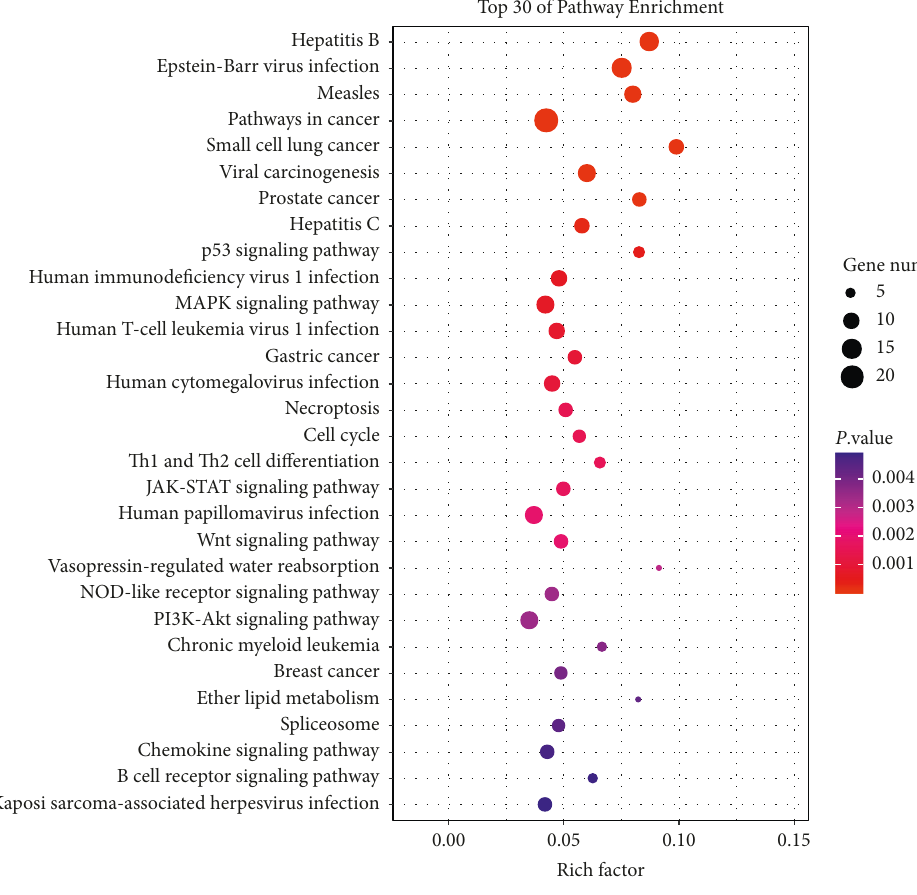
Figure 5: Scatter plot of KEGG pathway enrichment results. The top 30 KEGG enrichment pathways of DEGs.